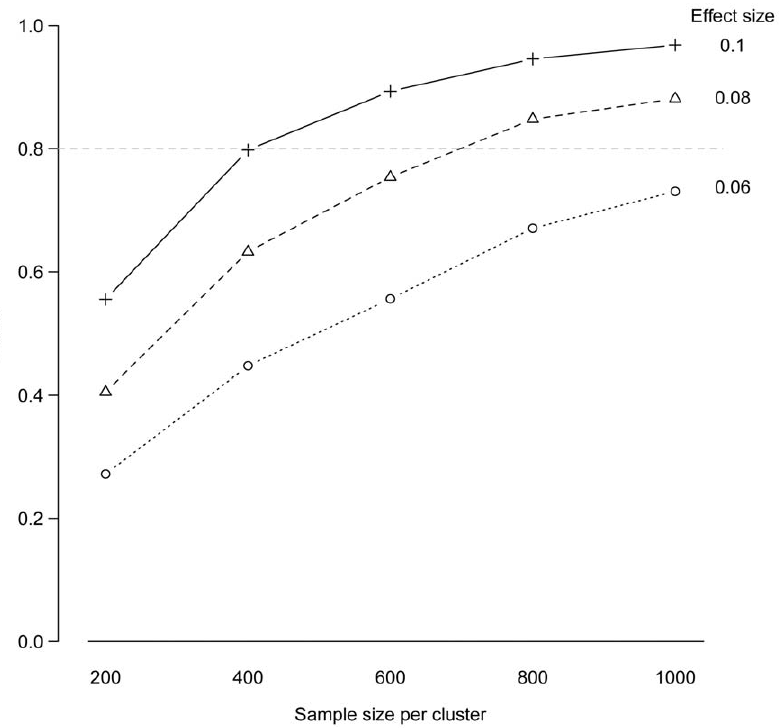
Figure 2. Power curves from Example C. These curves depict the relationship between power and sample size per cluster across different effect sizes. The points show simulated power for 500 datasets.